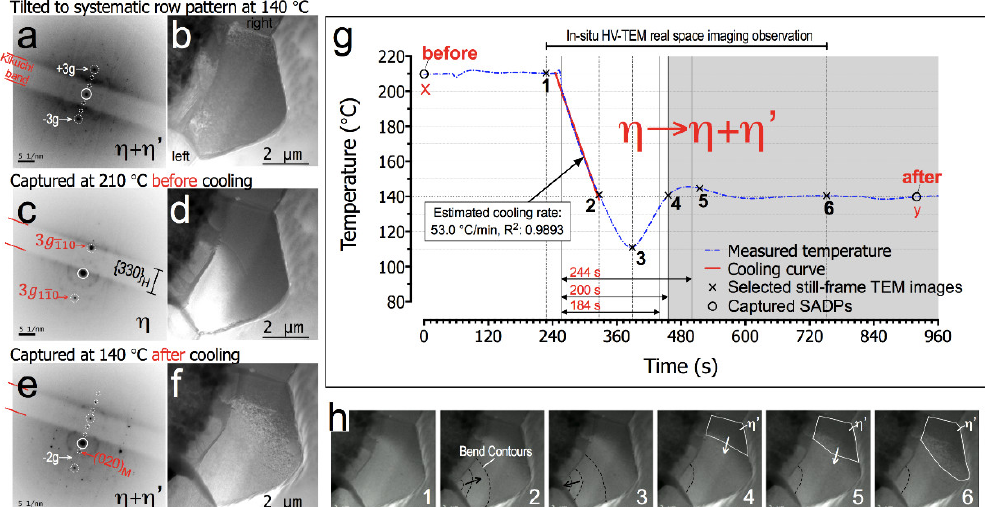
Figure 5. ( a , c , e ) bright-field plasmon-filtered TEM images corresponding to captured SADPs in ( b , d , f ); ( g ) Temperature profile of the in-situ HV-TEM observations; ( h ) selected still-frame TEM images from in-situ video taken at time points 1 to 6 in the temperature profile showing the observation analysis. Video of the in-situ cooling observation can be seen in Supplementary Video S1.